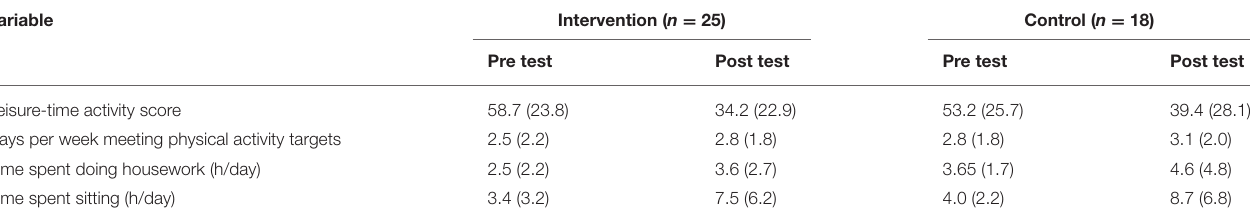
TABLE 7 | Physical activity before and after a dance/movement workshop intervention.